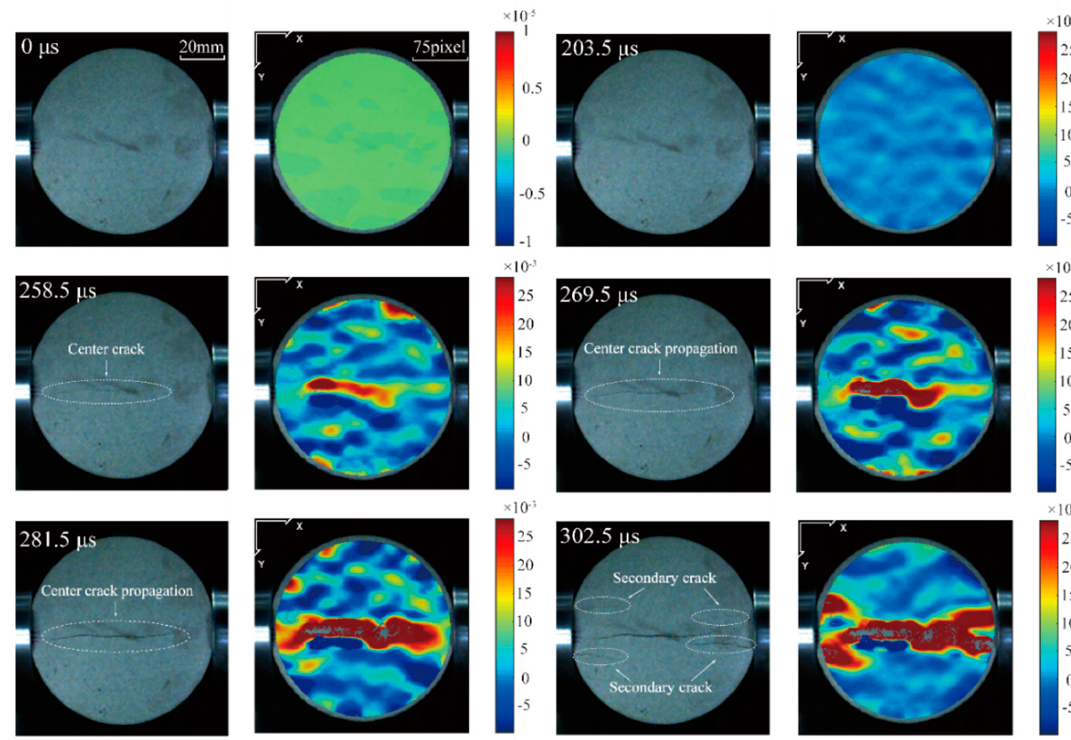
Figure 10. Progressive fracture process of a dry FBD specimen under coupled static–dy- namic